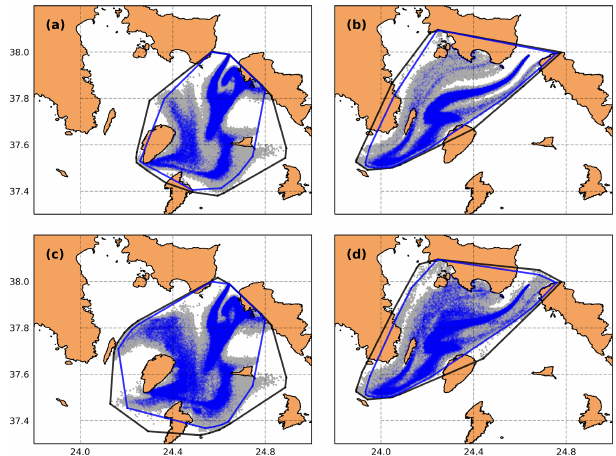
Figure 8. Convex hulls of the deterministic (blue dots and outer line) and all ensemble members (gray dots and outer line) consid- ering only surface and oil parcels deposited on the coasts (API 31) with forecast time 168h in (a) winter and (b) spring; (c, d) same as (a) and (b) , but for all parcels (i.e., surface, subsurface, and oil parcels deposited on the seabed and on the